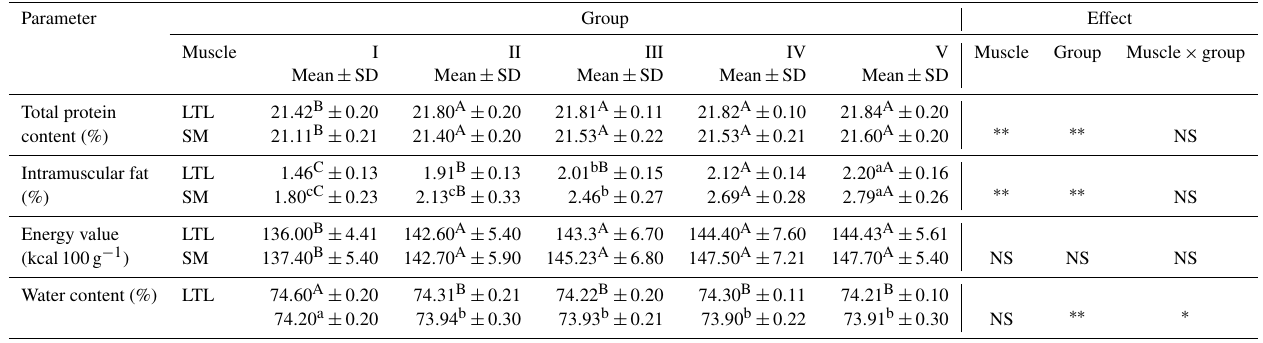
Table 4. Nutritional value of meat from female wild boars ( Sus scrofa scrofa L.) of different carcass weights. Parameter Group